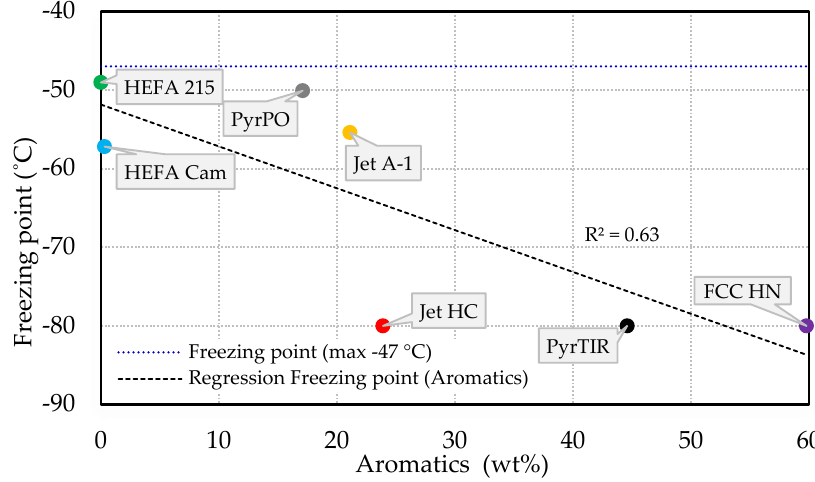
Figure 6. Freezing point relation to the aromatics for the samples studied.